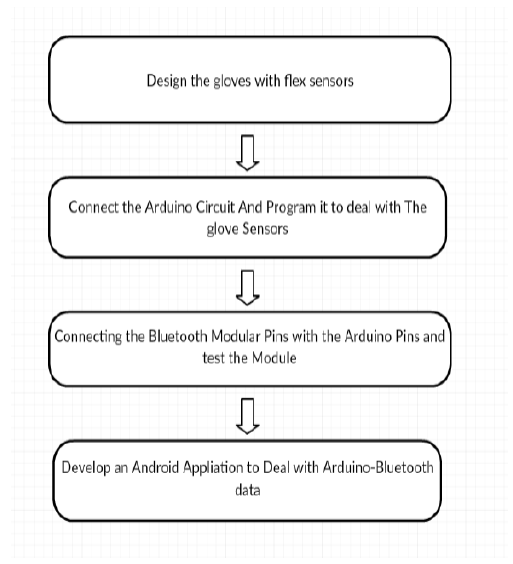
Figure 1: Flow of Chart of the Proposed System.